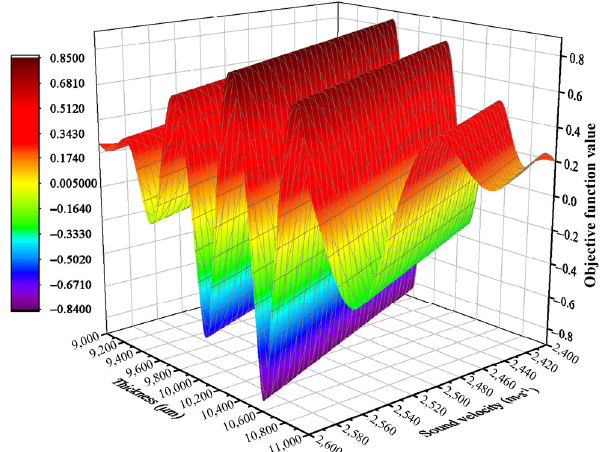
Fig. 13 Solution space of the dual objective function with respect to sound velocity and